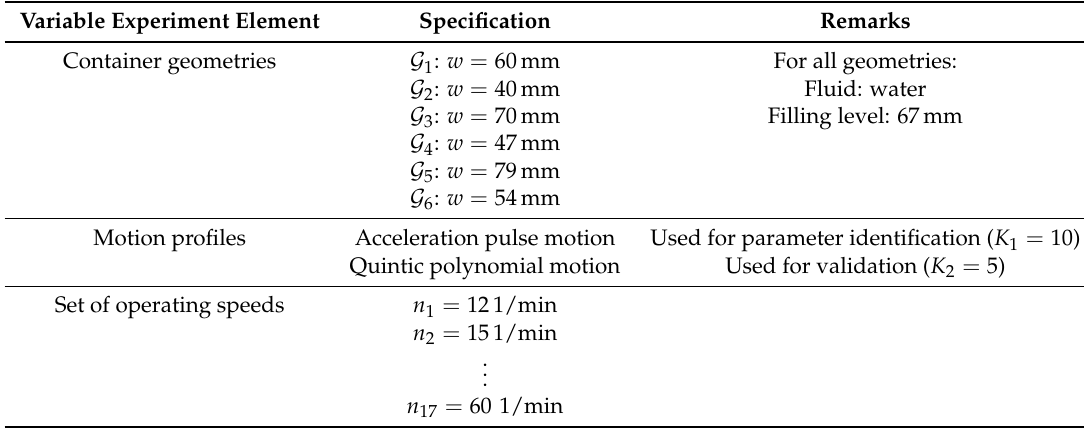
Table 2. Specification of experimental design for creating parameter identification and validation data.